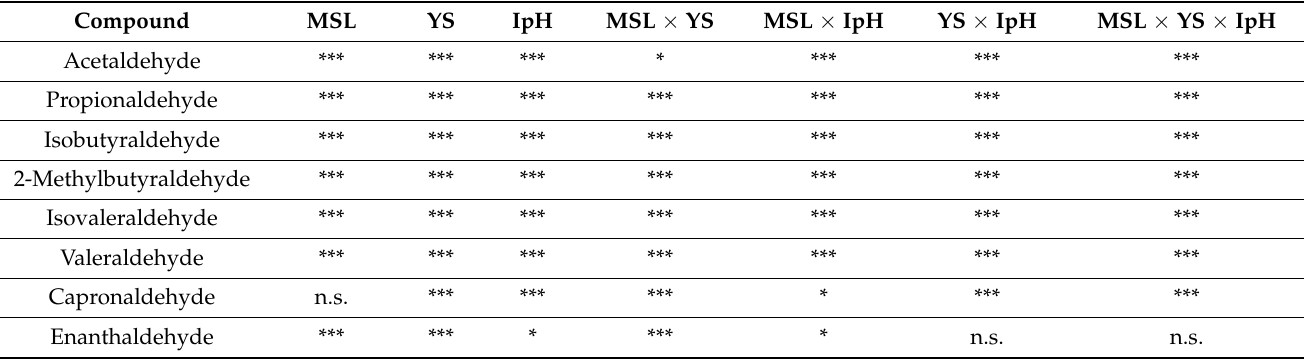
Table 8. Results of three-way